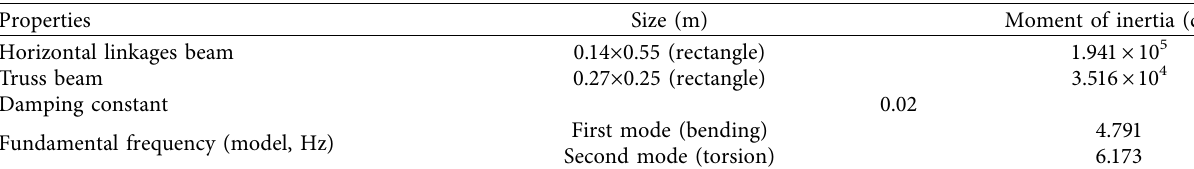
Figure 13: First six modes of the truss-arch bridge. (a) First mode. (b) Second mode. (c) Third mode. (d) Forth mode. (e) Fifth mode. (f) Sixth mode. Table 6: Bridge properties.